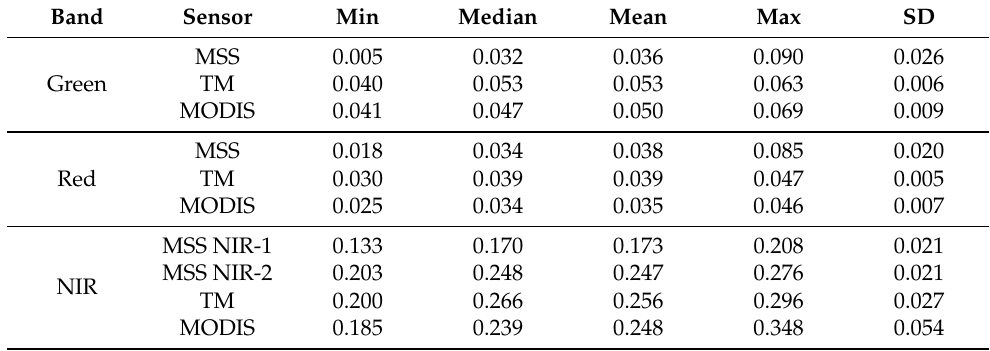
Table 10. Statistics of time-series reflectance of MSS, TM, and MODIS in ROI 3 (ROI 3: vegetation). Band Sensor Min